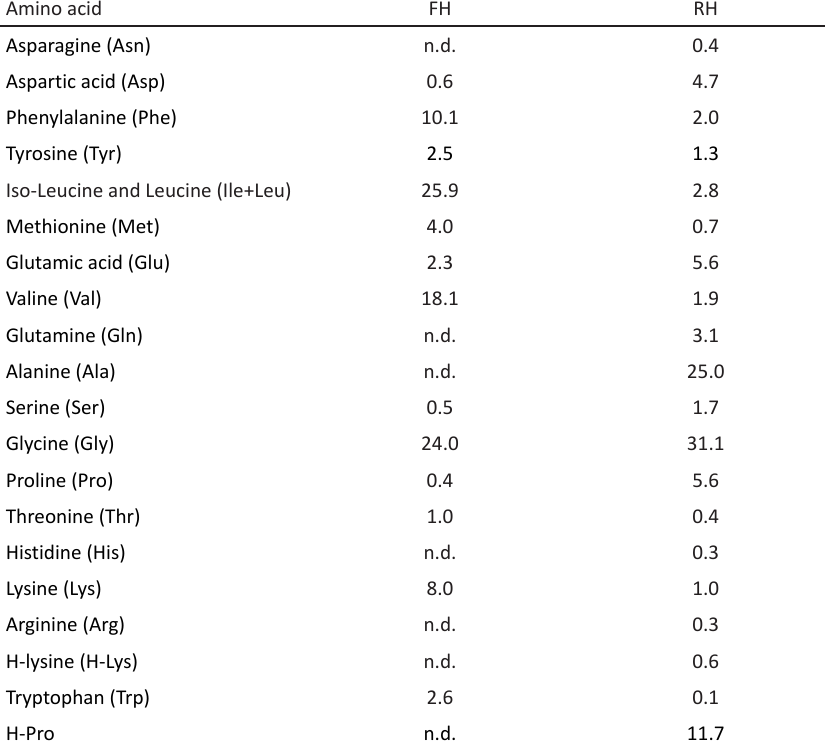
Table 1. Composition of the chicken feather hydrolysate (FH) and the reference hydrolysate (RH) used in the pot and the field experiments in 2017 Amino